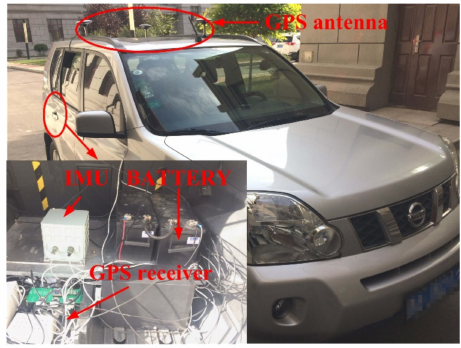
Figure 7. The experimental equipment.